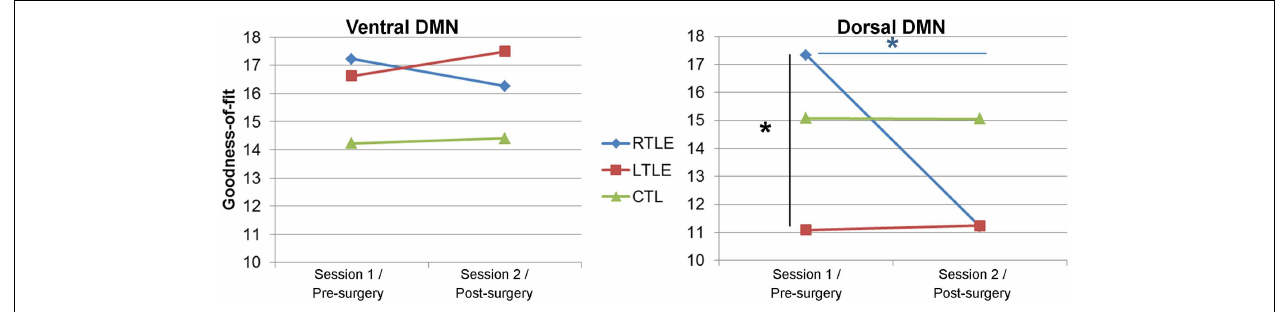
FIGURE 2 | Goodness-of-fit (GOF) for each default-mode network. Left panel: dorsal DMN (dDMN), right panel: ventral DMN (vDMN). *Significant difference at p < 0.05.